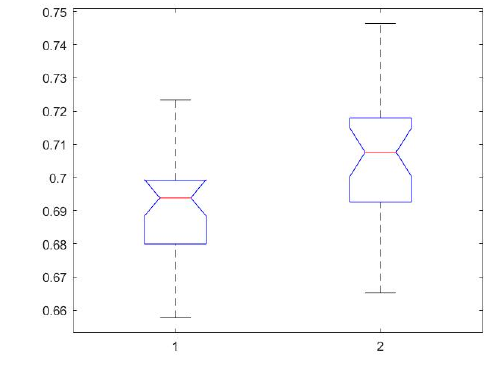
MAPE indicator. The result indicates a similarity between the MAPE values.